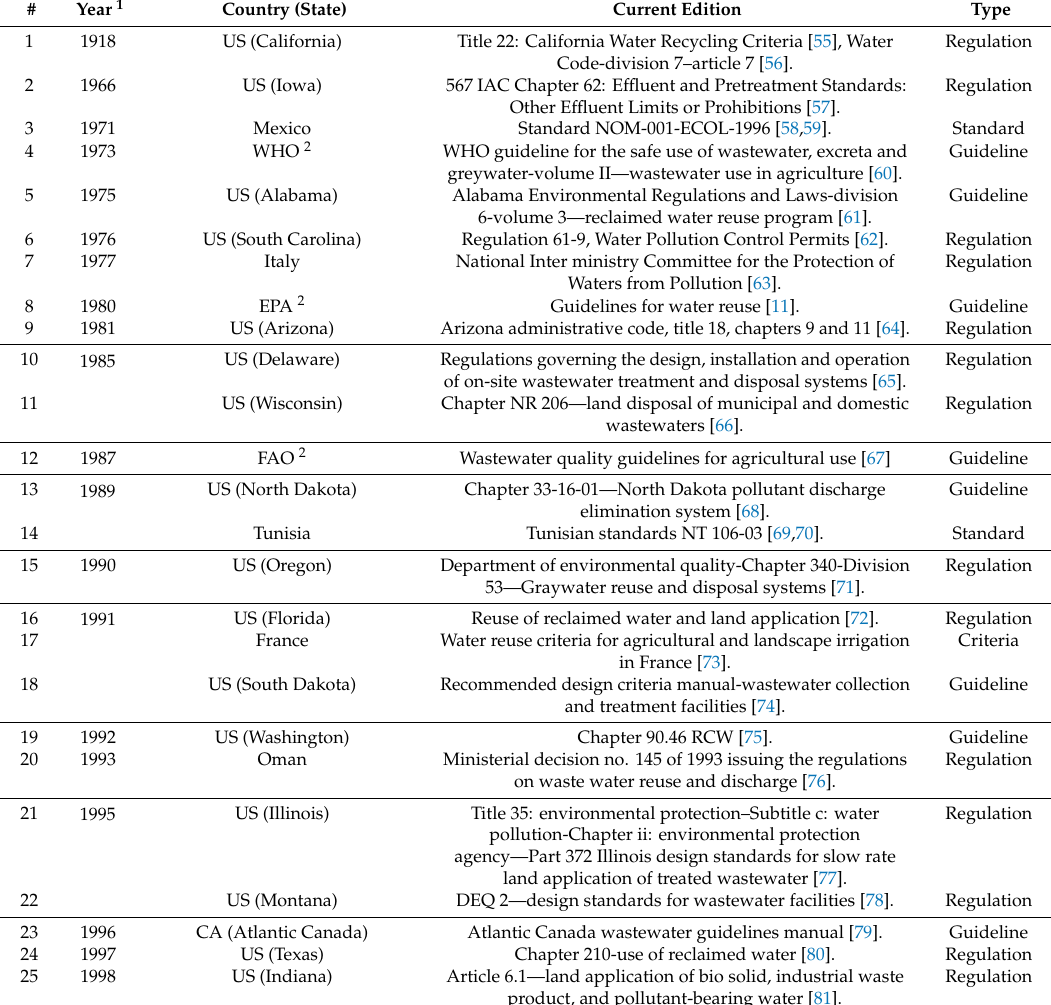
Table 3. Agricultural water reuse regulations or guidelines included in this